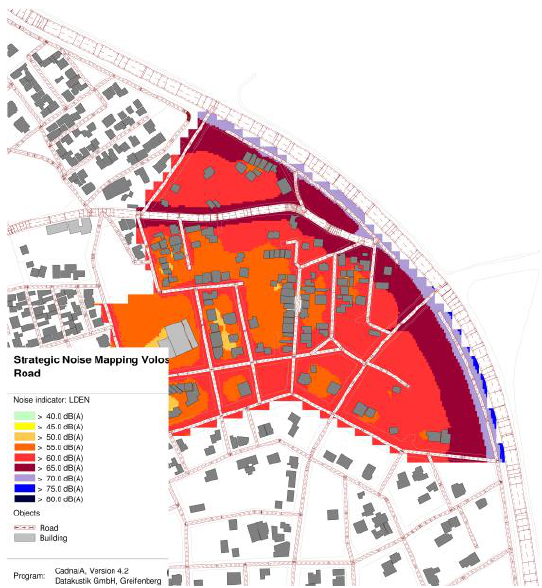
Figure 4. Strategic Noise Map (SNM): L den index simulation in Karagats urban area, Volos, Greece.